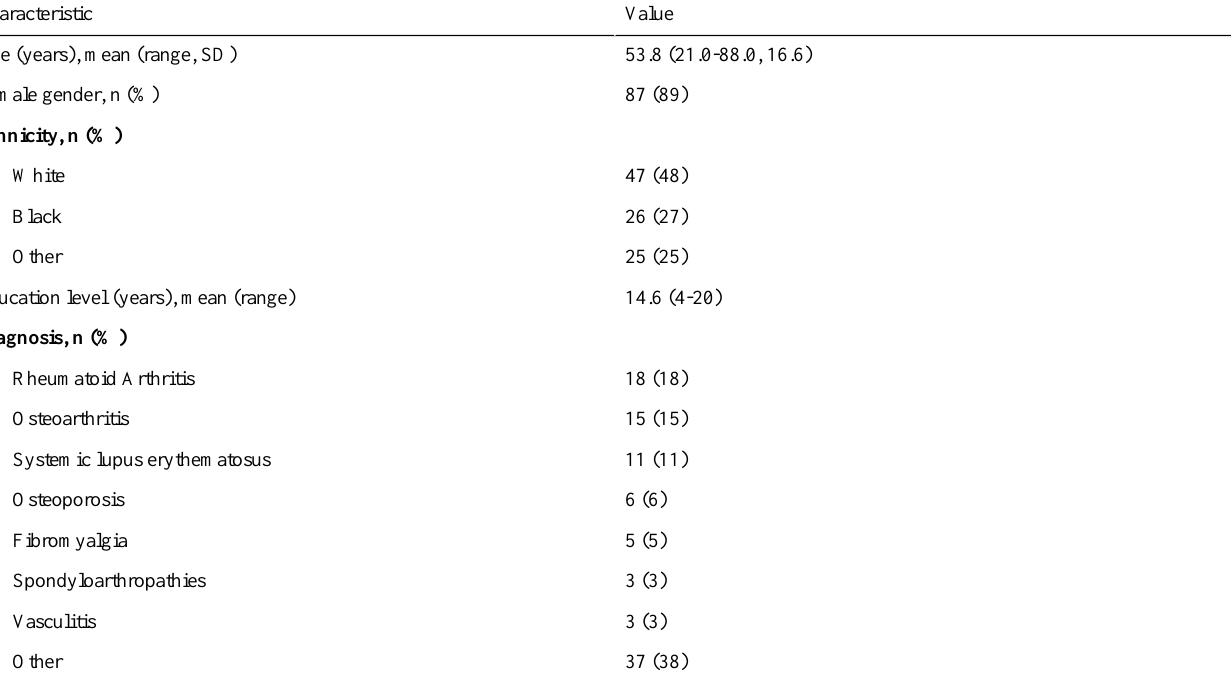
Table 1. Demographic characteristics and diagnoses of the patients included in the study (N=98). ValueCharacteristic